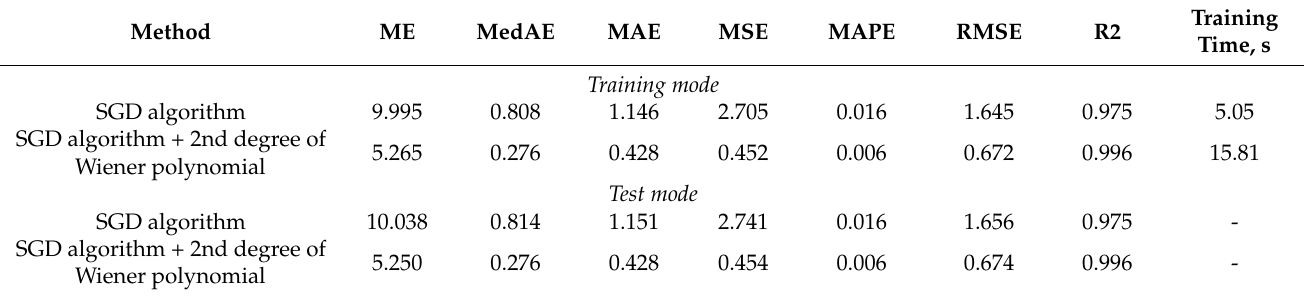
Table 3. Performance indicators for different Wiener polynomial